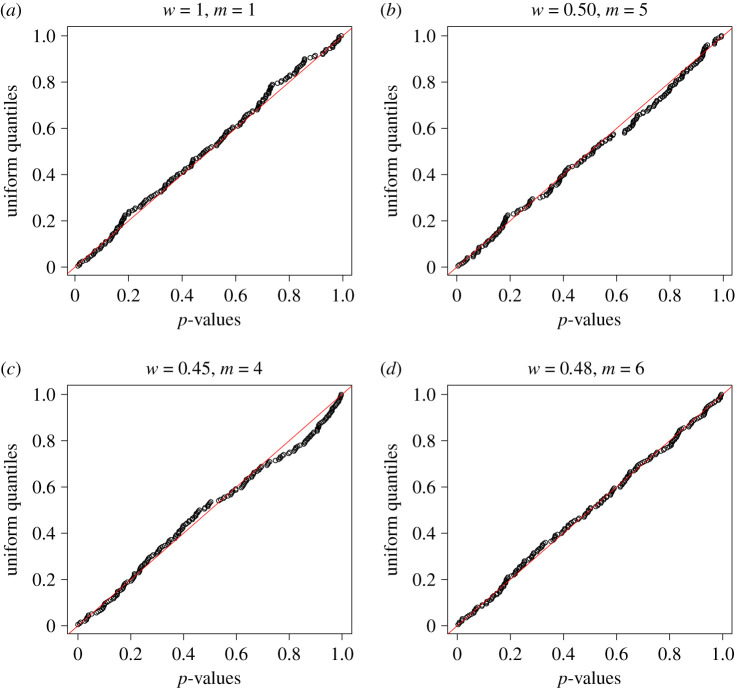
We present some qqplots of pvalues versus the quantiles of a uniform distribution, simulations performed using different parameter settings. (a) w = 1, m = 1, (b) w = 0.50, m = 5, (c) w = 0.45, m = 4, (d) w = 0.48, m = 6. (Online version in colour.)